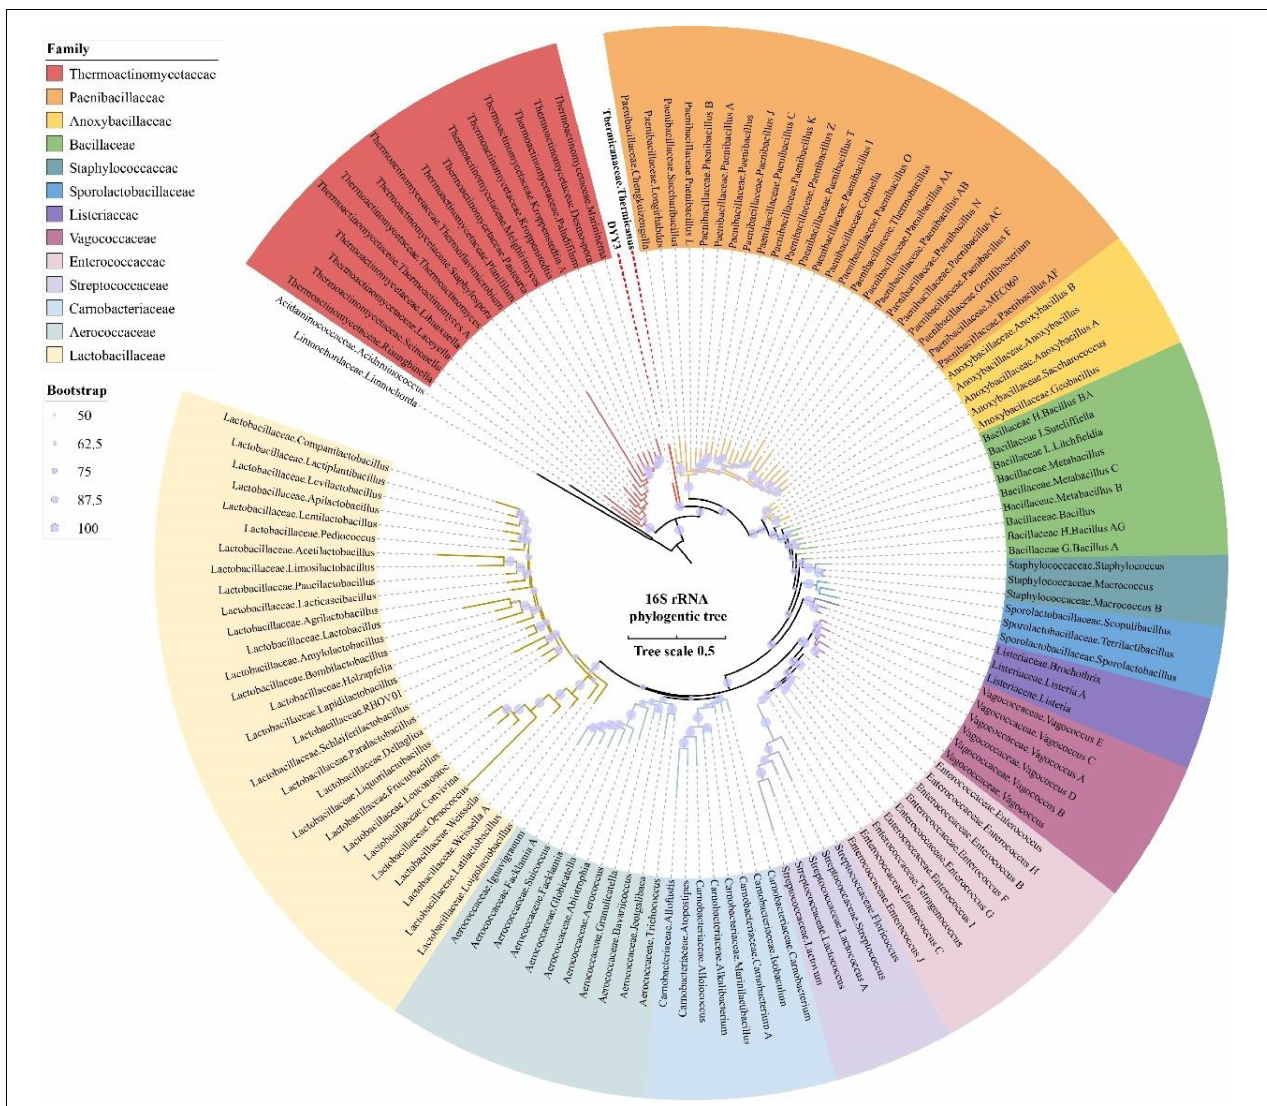
FIGURE 2 | 16S rRNA gene tree of strain DYY3. The rooted 16S rRNA gene ML tree was constructed by RAxML utilizing the typical species of Bacilli and also the matched species on NCBI with a bootstrap value of 1,000. Acidaminococcaceae, Acidaminococcus, Limnochordaceae, and Limnochorda were set as the out-group, and the other species were Bacilli in